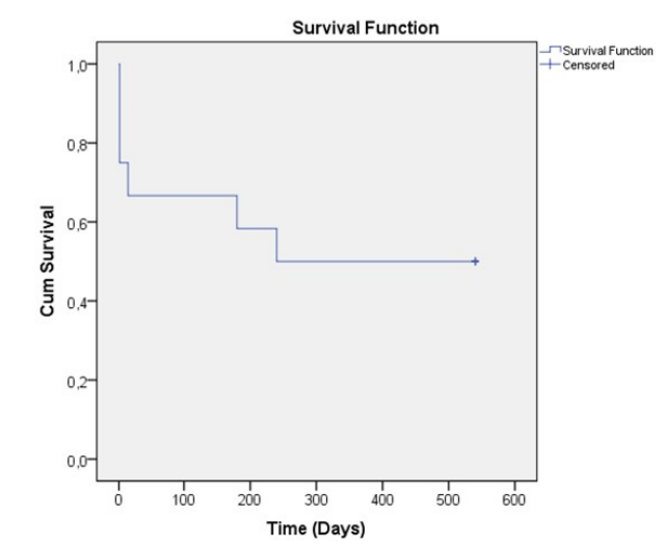
Figure 7. Kaplan-Meier survival estimates graph for treatment “success” at latest follow-up (intraocular pressure < 21mmHg; intraocular pressure lowering > 20%; no reoperation). The axis “x” shows time and the axis “y” (“cum survival”) shows the IOP after the intervention. As it can be seen from the graph, the IOP remains stable over time. visual field testing with automated perimetry. We demonstrated that no progression of 142 visual field damage Figure 8) and no significant change in the status of RNFL (Figure 9) has been observed.